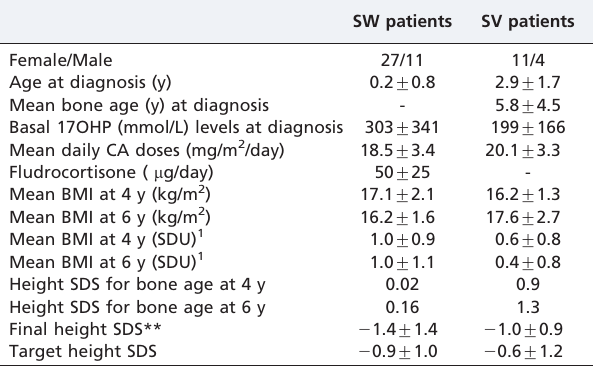
Table 1 - Clinical, auxological and hormonal data of 53 patients with CAH.